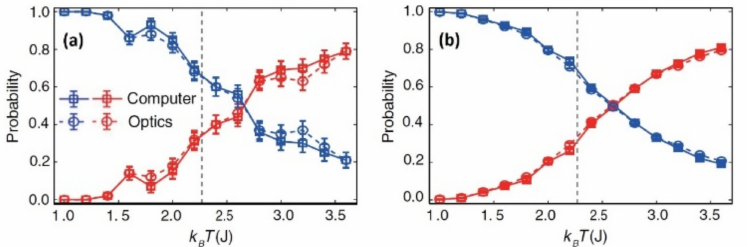
Figure 4. Average possibility of right (blue) and wrong (red) classification of this stage subject to temperature T (K) for 100 ( a ) and 4000 ( b ) settings